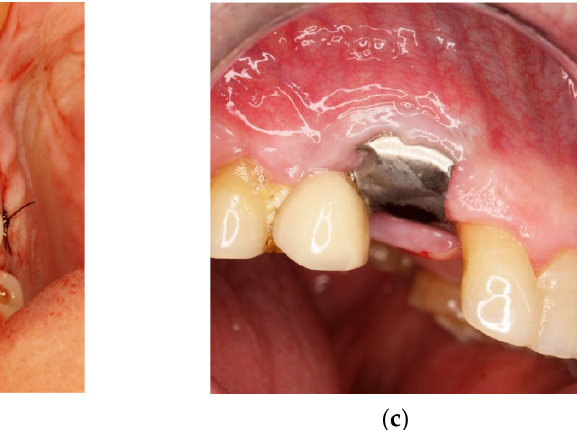
Figure 8. ( a ) Protection of the alveolus with titanium foil; ( b ) titanium foil; ( c ) follow-up at 6 months. Six months after surgery, the high quality and stability of soft tissues was observed (Figure 8c).